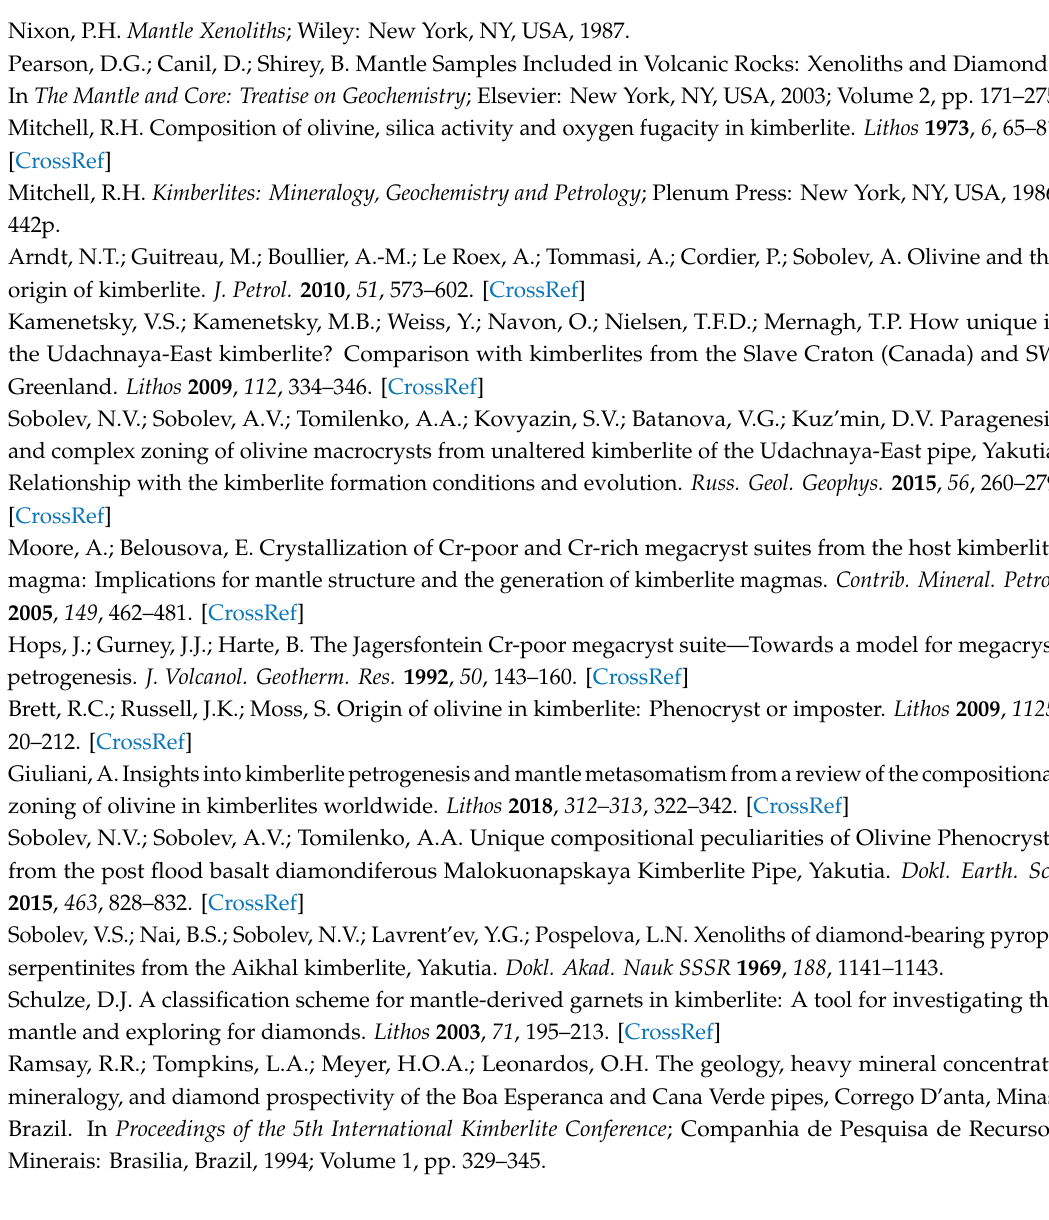
Table S1: Composition of xenogenic olivines from a number of Siberian